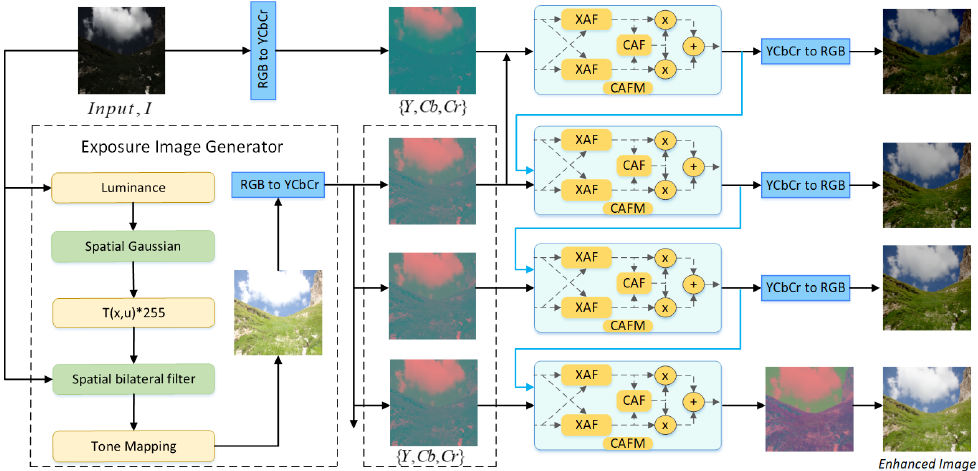
Figure 2. Overall structure of EFCANet. CAFM is Cross-Attention Fusion Module, and XAF is cross-attention fusion. CAF is Channel Attention